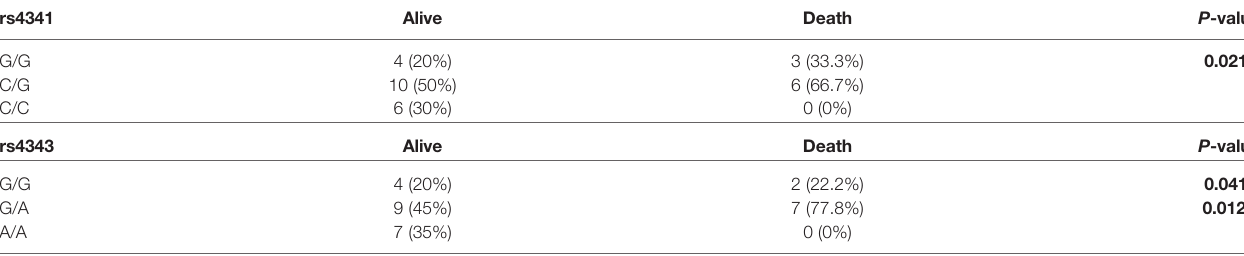
TABLE 3 | ACE genotype frequencies of COVID-19 patients in ICU who survived or who died. rs4341